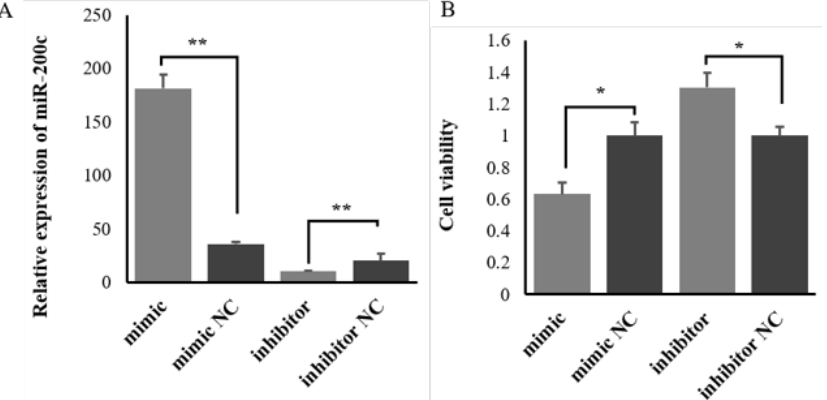
Figure 2. The effect of miR-200c on the viability of ovine MECs. ( A ) The relative expression levels of miR-200c when miR-200c mimic and miR-200c inhibitor were transfected into ovine MECs. ( B ) The viability of ovine MECs detected using CCK8 assay when miR-200c mimic and miR-200c inhibitor were transfected into ovine MECs. ** p < 0.01 and * p < 0.05.